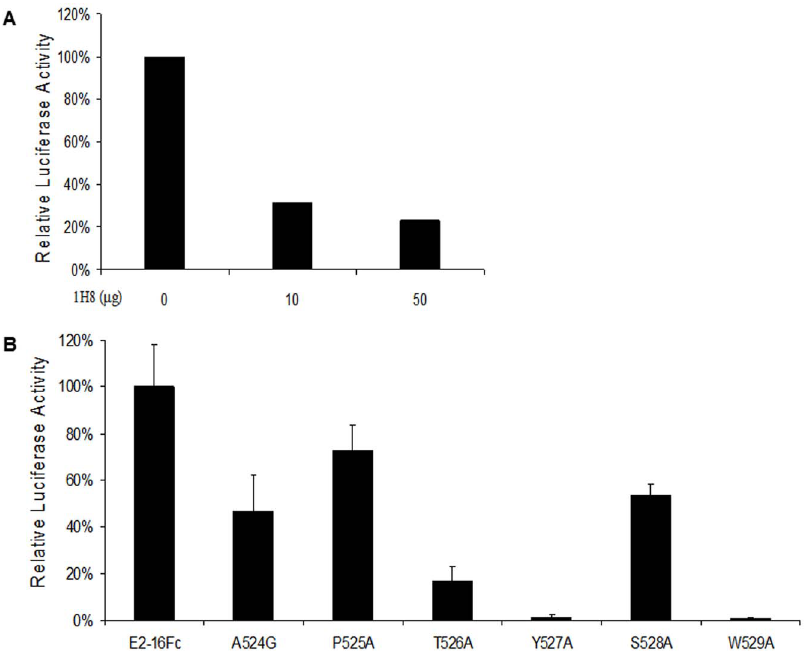
Figure 5. The role of amino acids of the 1H8 binding site in the CD81 interaction of the E2 protein. (A) E2-16Fc was incubated with the Protein A pre-coated 96-well plates at 100 m L/well at room temperature for 1 hour. 30 m L supernatants containing 2.5 6 10 6 units of luciferase activity of CD81-Luc was added to each well in the presence or absence of 1H8, and incubated for an additional hour. After an extensive washing, the luciferase activity was measured. The x-axis indicates the 1H8 used in the assay. The y axis indicates the relative luciferase activity, representing the direct interaction between E2-16Fc and CD81-Luc. (B) The interaction of E2-16Fc and its mutants with CD81-Luc was determined under similar experimental conditions as described in (A). The y-axis indicates the relative luciferase activity, representing the direct interaction of E2-16Fc or its mutant with CD81-Luc.